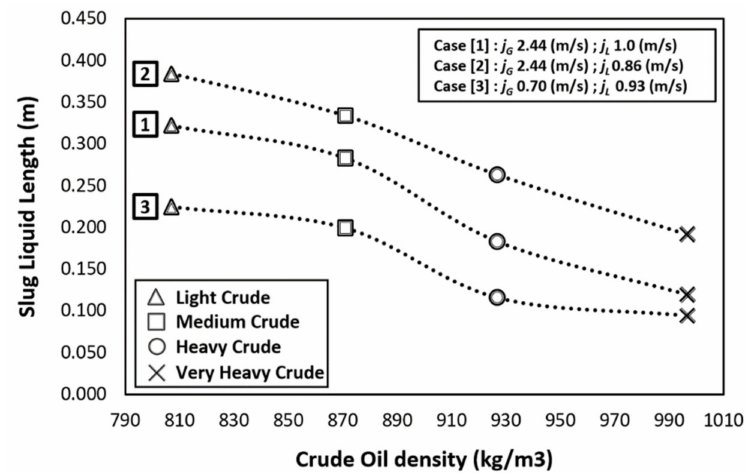
Figure 12. Effect of varying crude oil grades on slug liquid